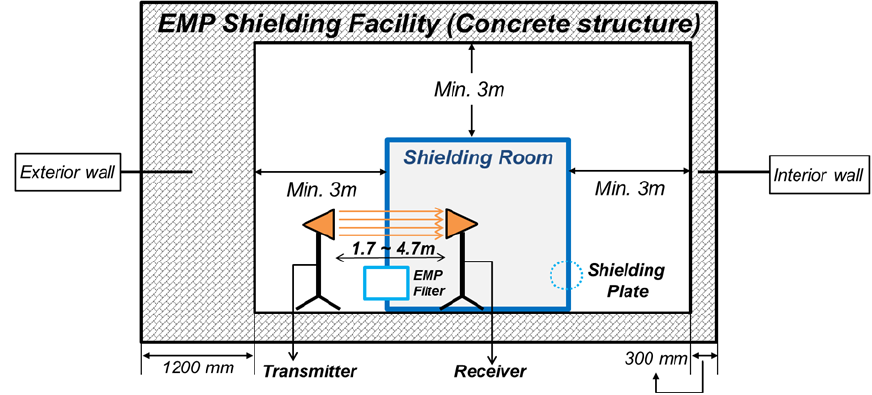
Figure 1. Floor plan of a conventional electromagnetic pulse (EMP) shielding facility.